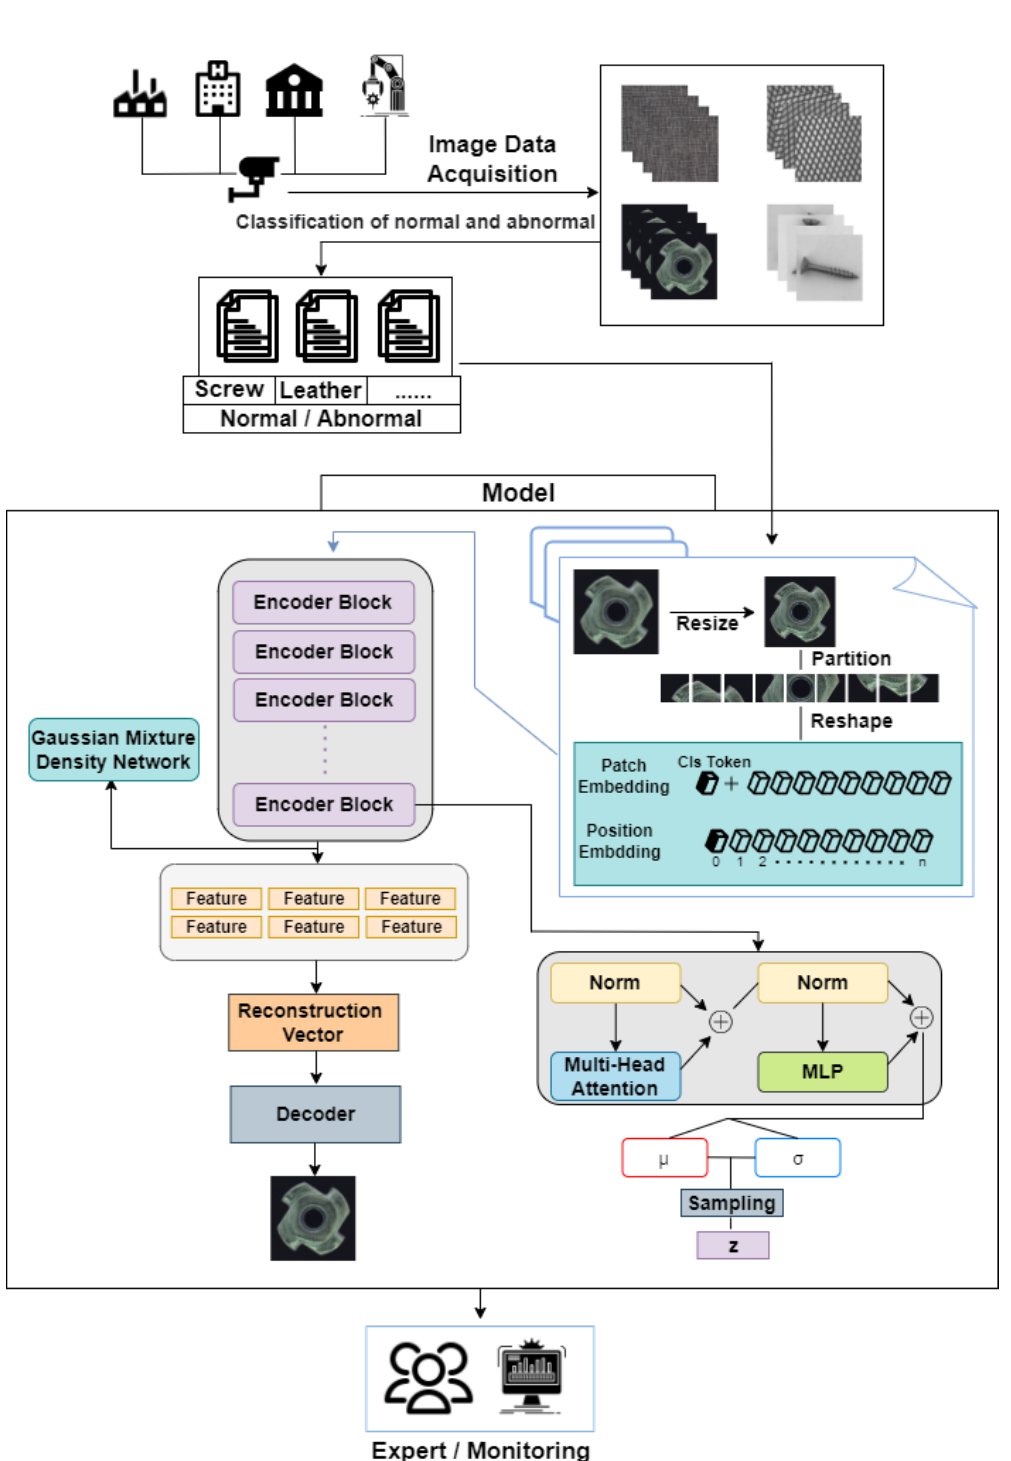
Figure 2. Proposed ViV-Ano